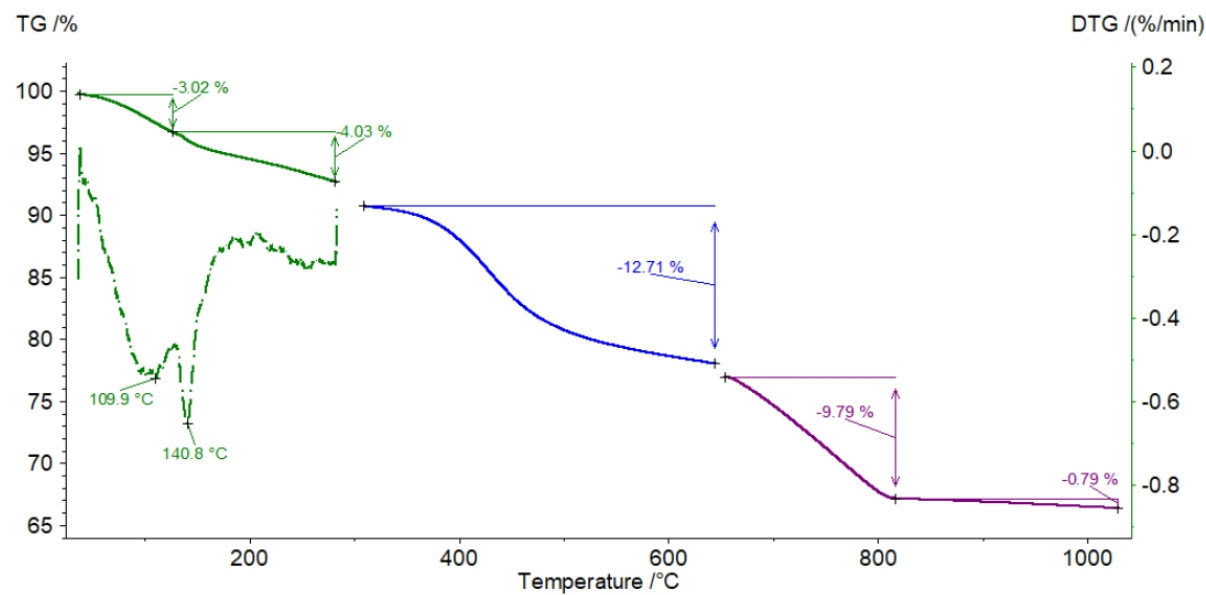
Figure 3. An example of the thermogravimetric analysis for Sample 1. Weight loss in subsequent non-isothermal stages is determined from the TG curve (solid line). The DTG curve (dashed line) enables the T TG temperature to be determined. Table 2. Comparison of weight loss in samples representing Menilite Beds in the three-part Py/GC and TG analyses in relation to generation potential values. Menilite Beds—Outcrop Samples Py/GC TG RE Location Sample No.